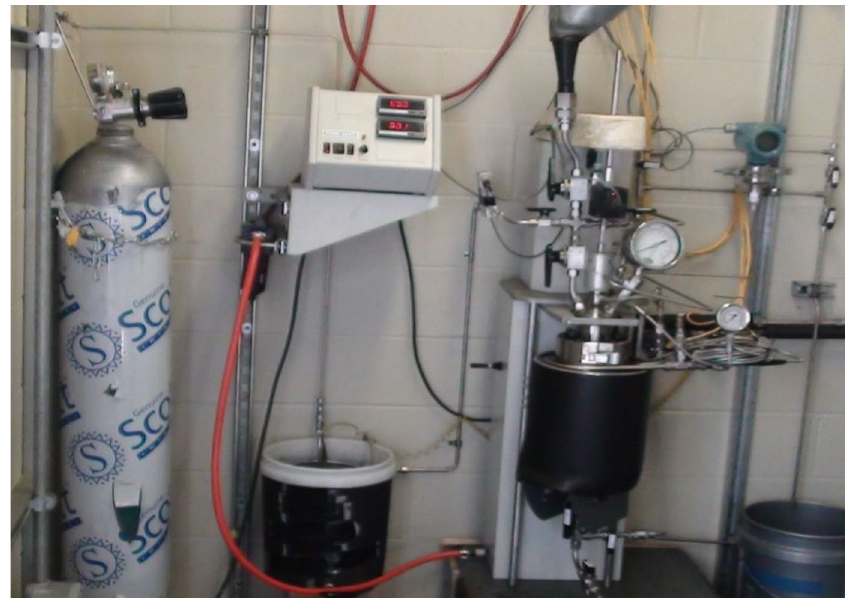
Fig. 10 Small-scale facility